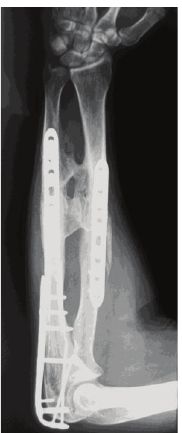
Figure 2: The intraoperative view shows a bone ankylotic bridge of 10 cm length and 2 cm